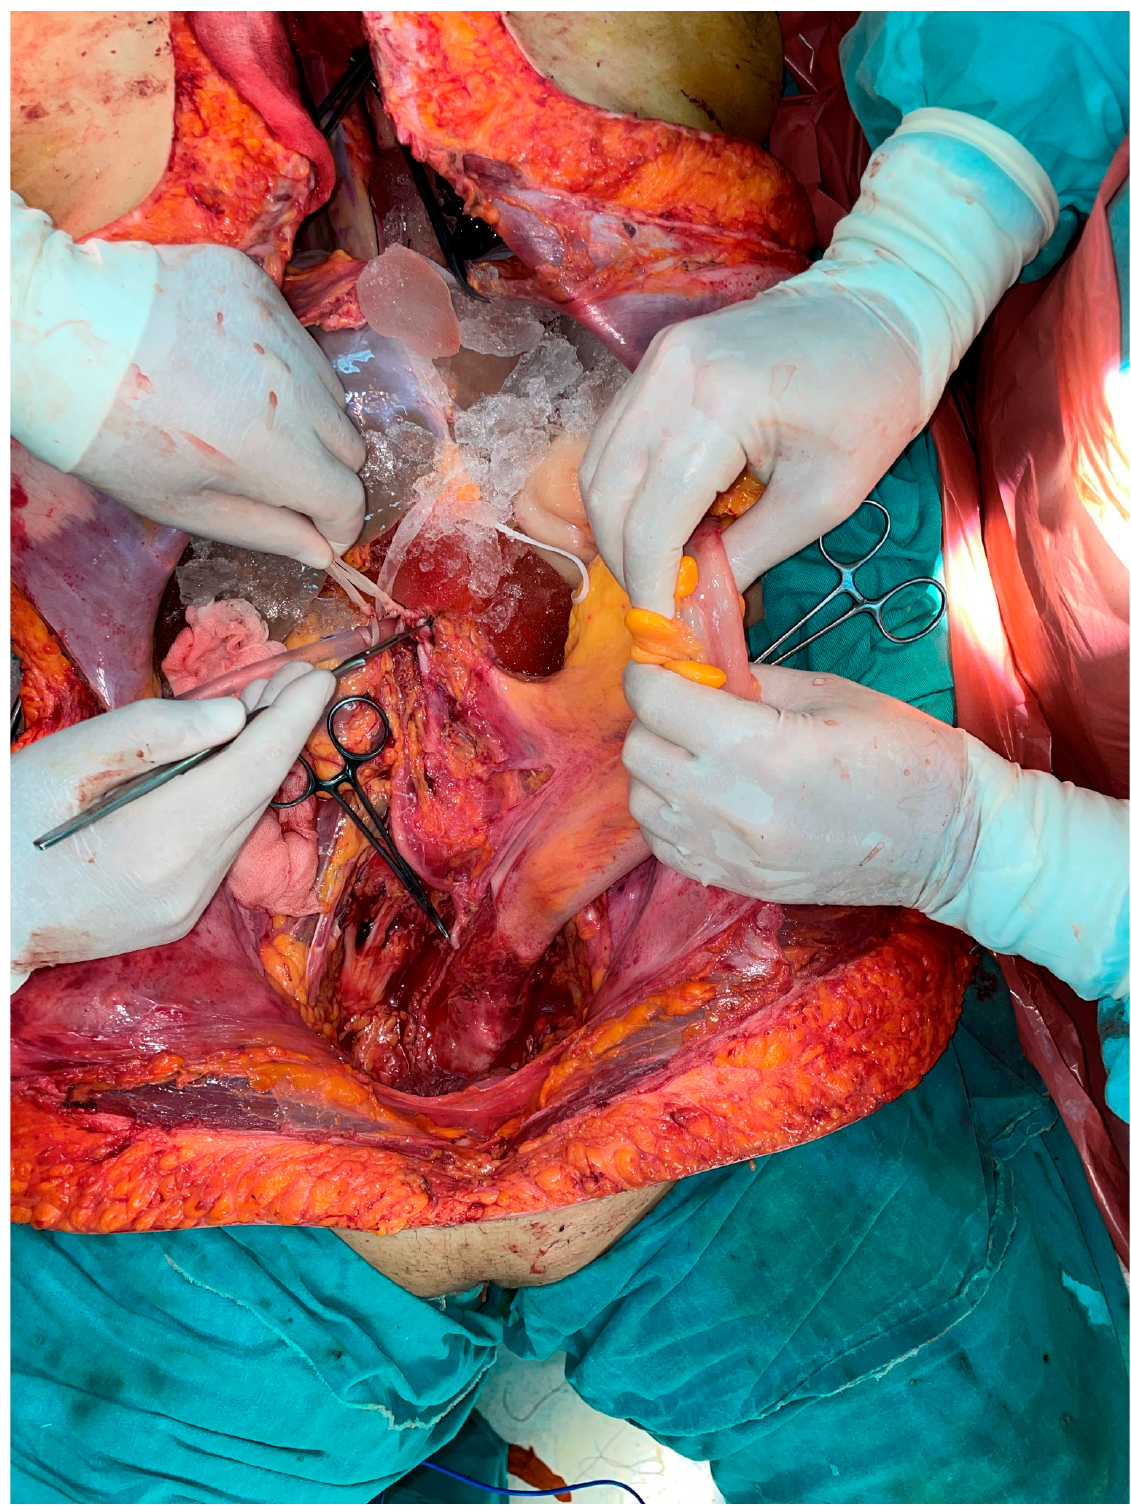
Figure 4. Situs after removal of uterine graft from donor. The deep pelvic structures are visible.